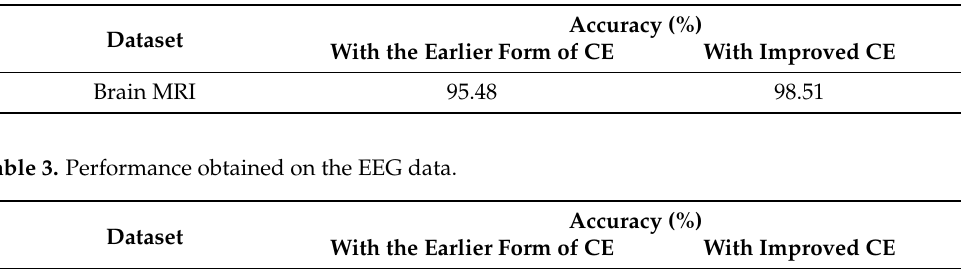
Table 2. Performance obtained on the brain MRI data.